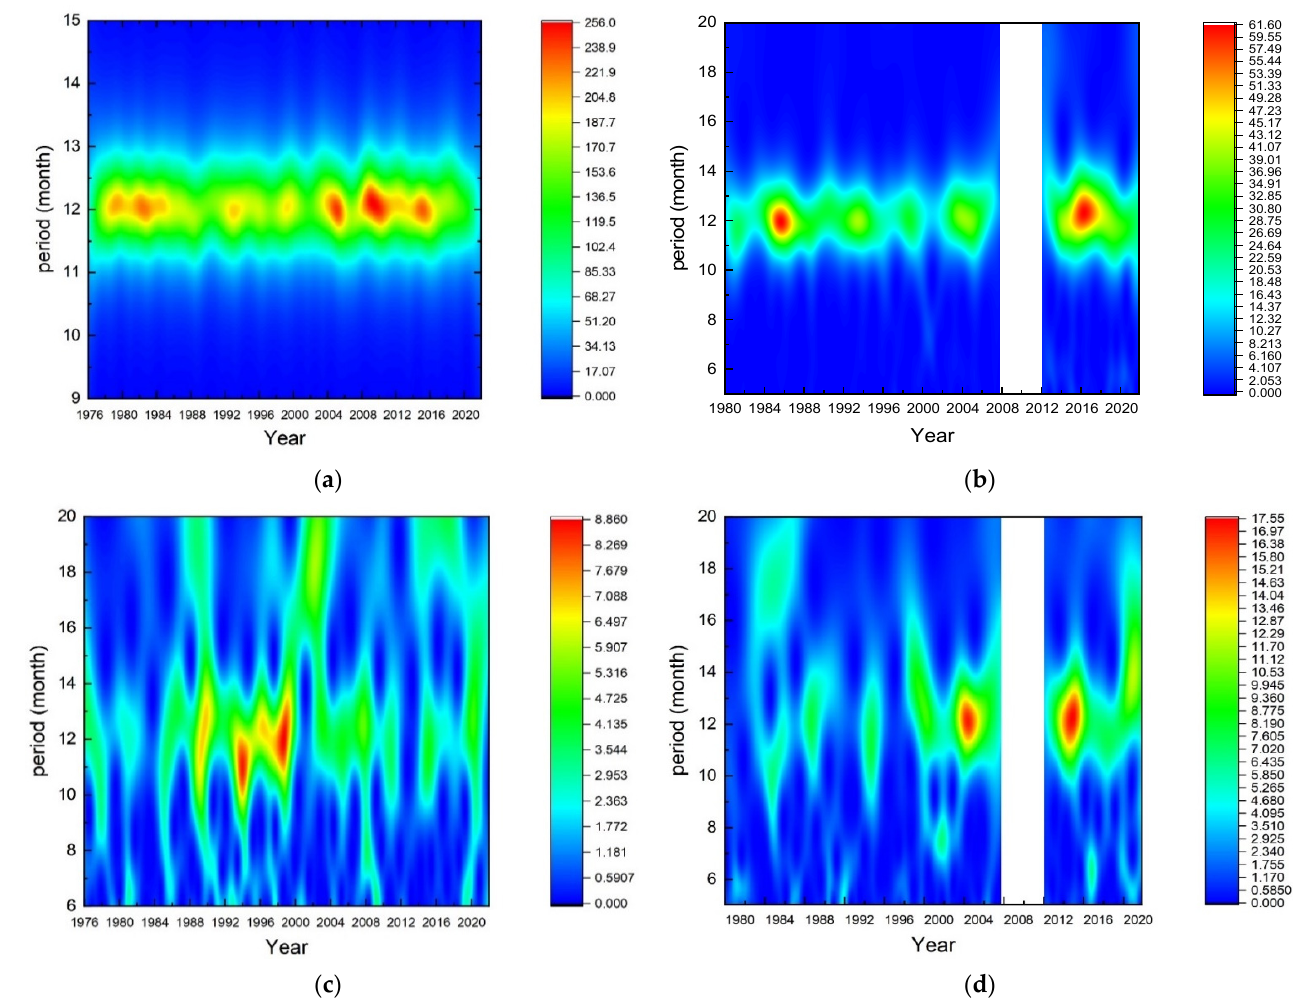
Figure 3. Wavelet analysis (WA) of the: ( a ) temperature; ( b ) δ 18 O; ( c ) precipitation amount, and ( d ) deuterium excess.